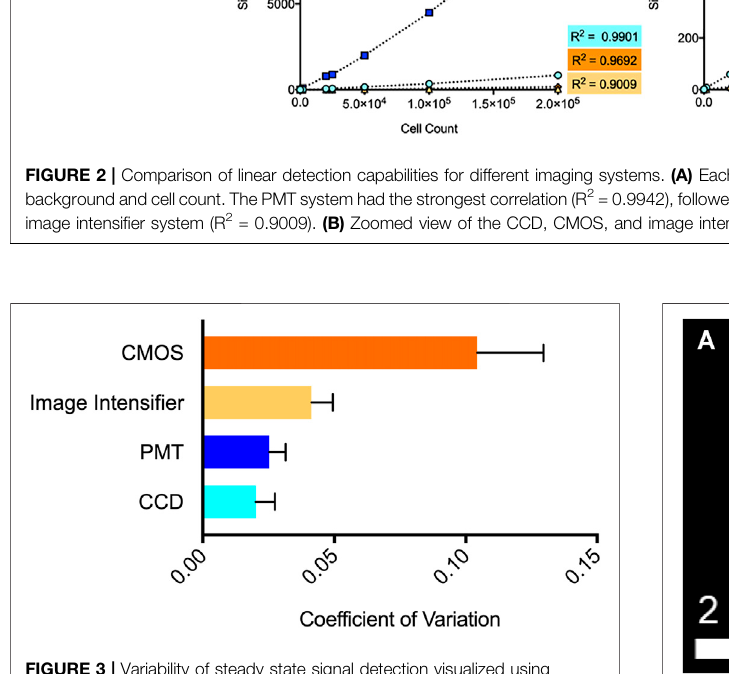
FIGURE 3 | Variability of steady state signal detection visualized using coef fi cientofvariation.TheCMOSsystemshowedthehighestvariability(CV (cid:2) 0.1043), followed by the image intensi fi er system (0.0414), PMT system (0.0252), and CCD system (0.0202). n (cid:2) 6; error (cid:2) S.E.M.